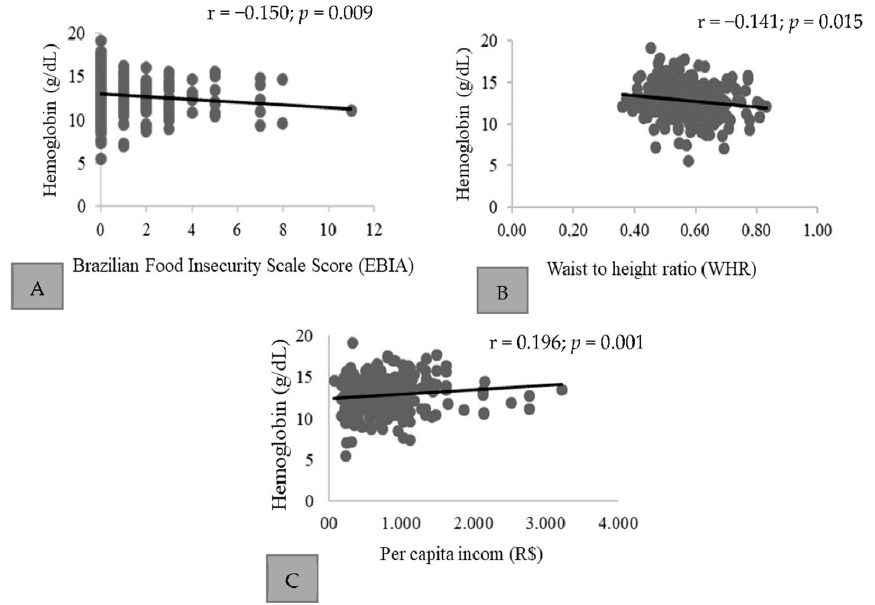
Figure 1. Correlation between hemoglobin values (g/dL), EBIA, WHR, and per capita income (BRL) of adults and elderly in rural households in a municipality of Brazil. Correlation was found between hemoglobin values, EBIA scores ( A ), and WHR values ( B ), while per capita income presented a positive correlation ( C ). Table 2. Prevalence of anemia in rural households in a municipality of Brazil, according to the assessment of food security, nutritional status, socioeconomic, demographic, and housing conditions.